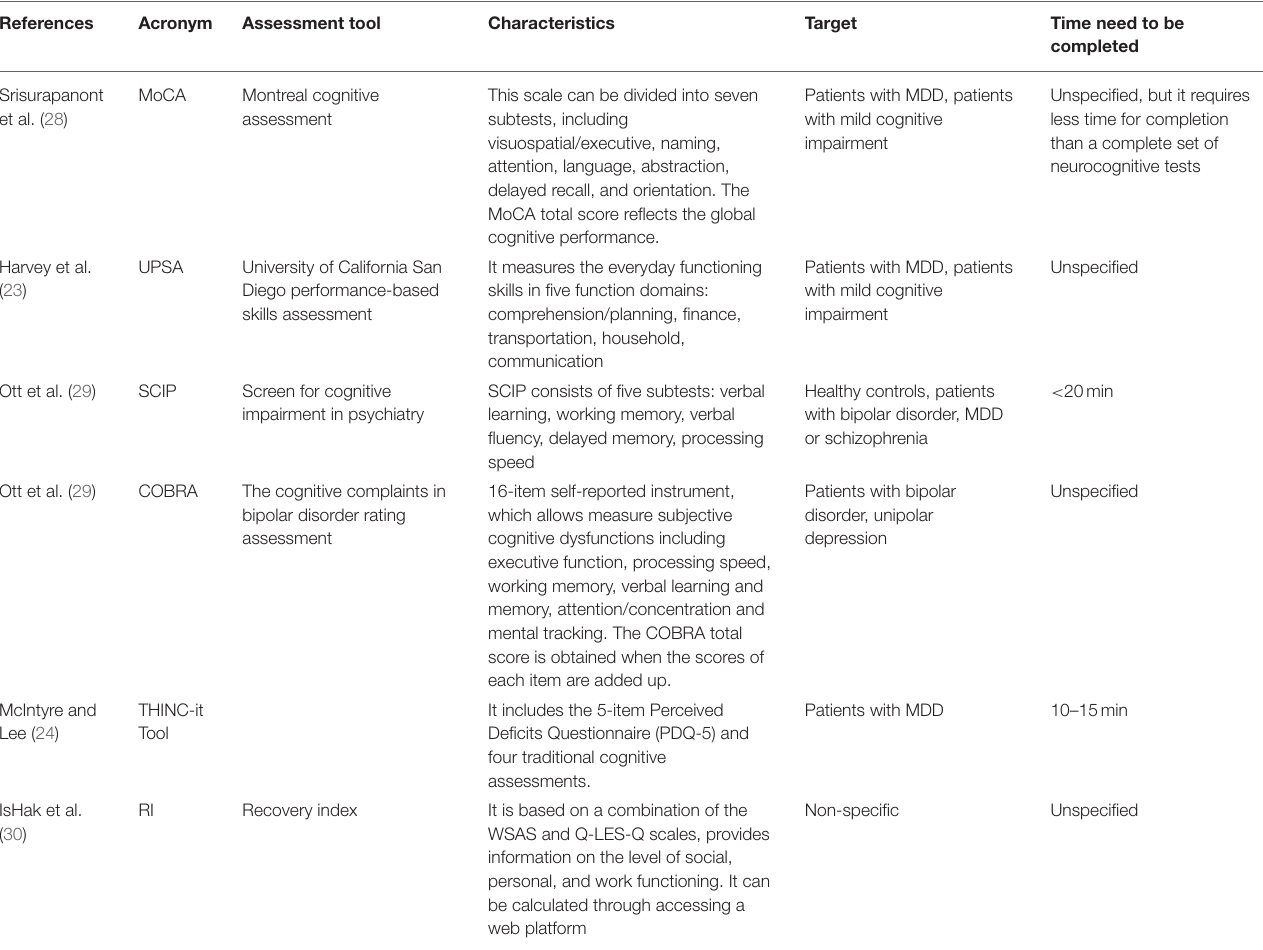
TABLE 1 | Assessment tools for evaluating cognitive and global functioning in patients with